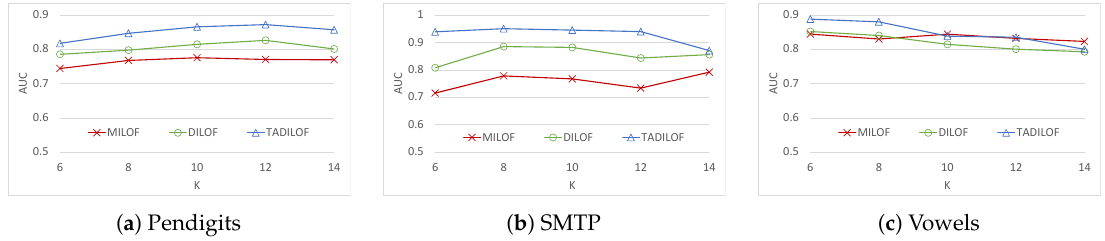
Figure 4. AUC on various datasets for different K values.